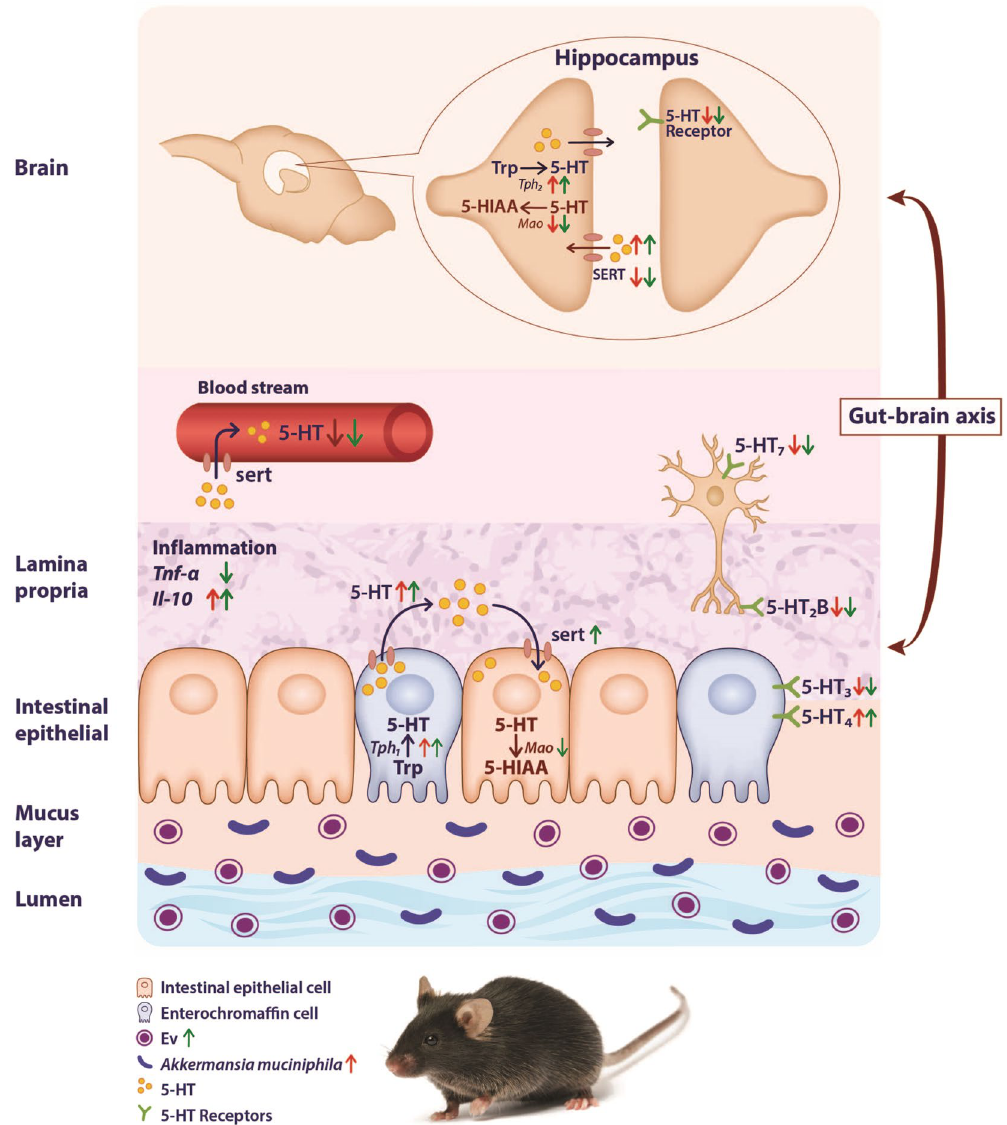
Figure 7. The oral administration of A. muciniphila and its EVs affected the serotonin pathway through the gut-brain axis in mice. This figure shows major intermediates, enzymes, and transporters in serotonin synthesis and clearance. Colonic and hippocampal serotonin synthesis increased through interactions with the bacterium and its EVs and upregulation of Tph1 gene in the colon and Tph2 gene in the hippocampus. Also, the increased serotonin availability in the colon of mice increased SERT expression in both groups. Conversely, the SERT expression decreased in the hippocampus of both groups. The Mao gene expression reduced following EV treatment in the colon and following both treatments in the hippocampus. Treatments with A. muciniphila and its EVs affected colonic inflammation and inflammation-related genes. Compounds: 5-HT = serotonin;